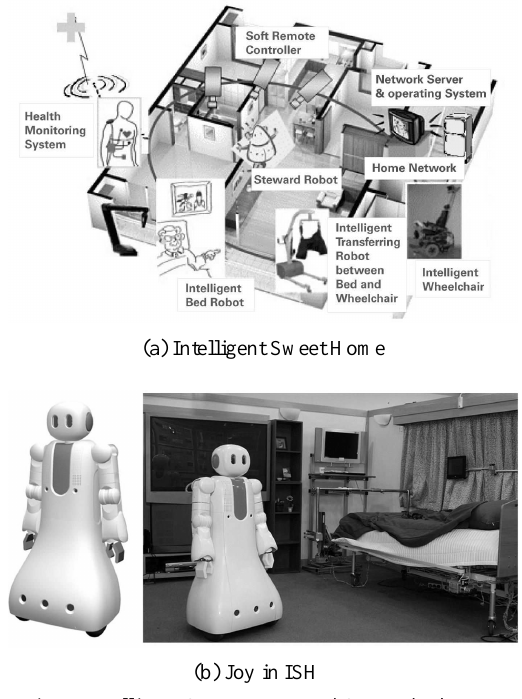
Fig. 1. Intelligent Sweet Home and Steward robot Joy